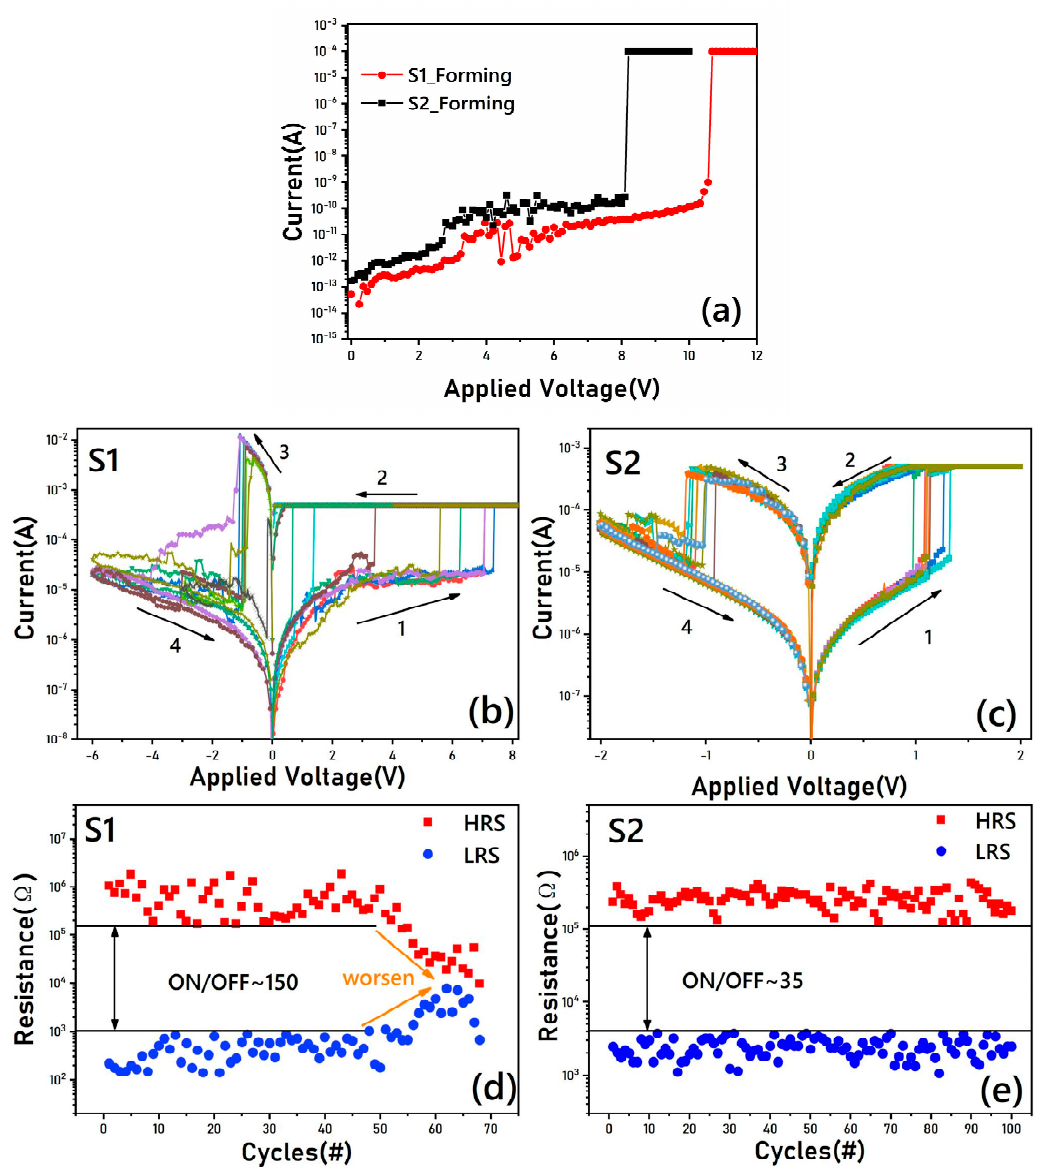
Figure 4. ( a ) The I-V diagram of the RRAM devices’ forming process; ( b ) I-V cycling characteristics RRAM with ICOMP = 0.5 mA; ( c ) I-V cycling characteristics of S2:ITO/LaAlO 3 /ITO RRAM with ICOMP = 0.5 mA; of S1:ITO/Al2O3/ITO RRAM with ICOMP = 0.5 mA; ( c ) I-V cycling characteristics of ( d ) Endurance test of S1 RRAM devices; ( e ) Endurance test of S2 RRAM S2:ITO/LaAlO3/ITO RRAM with ICOMP = 0.5 mA; ( d ) Endurance test of S1 RRAM devices; ( e ) Endurance test of S2 RRAM devices .